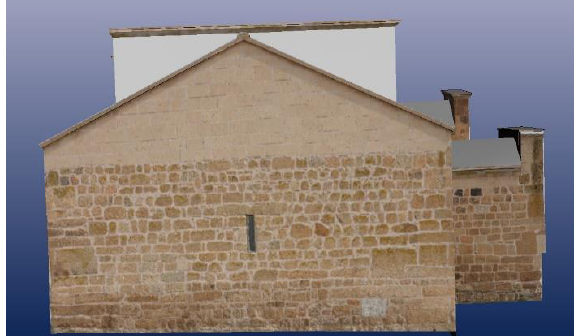
Figure 6. Covered surface sideline